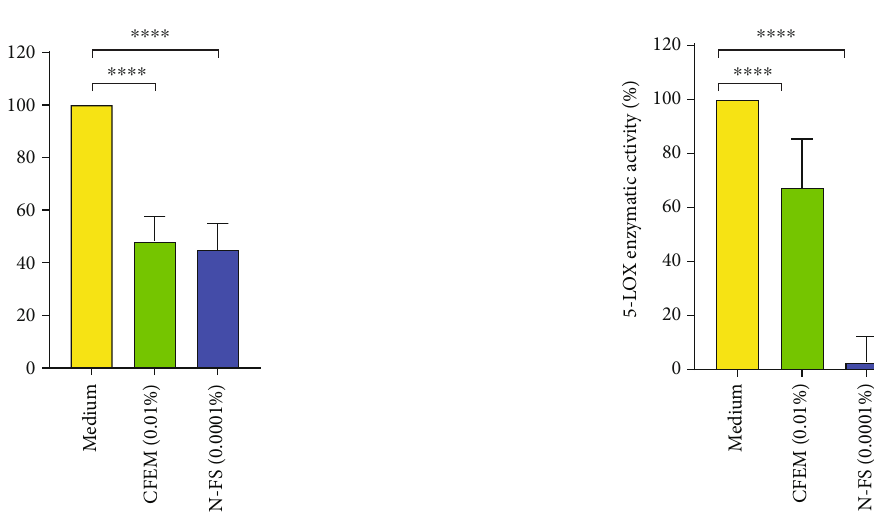
Figure 9: COX-2 enzymatic inhibition: endogenous COX-2 enzymatic activity in THP-1 cells di ff erentiated in macrophages (PMA). Macrophages pretreated with CFEM or N-FS (N- feruloylserotonin) for 1 hour. COX-2 induction (LPS) with the test substance for 24 hours. One-way ANOVA: ∗∗∗∗ p < 0 : 0001 .